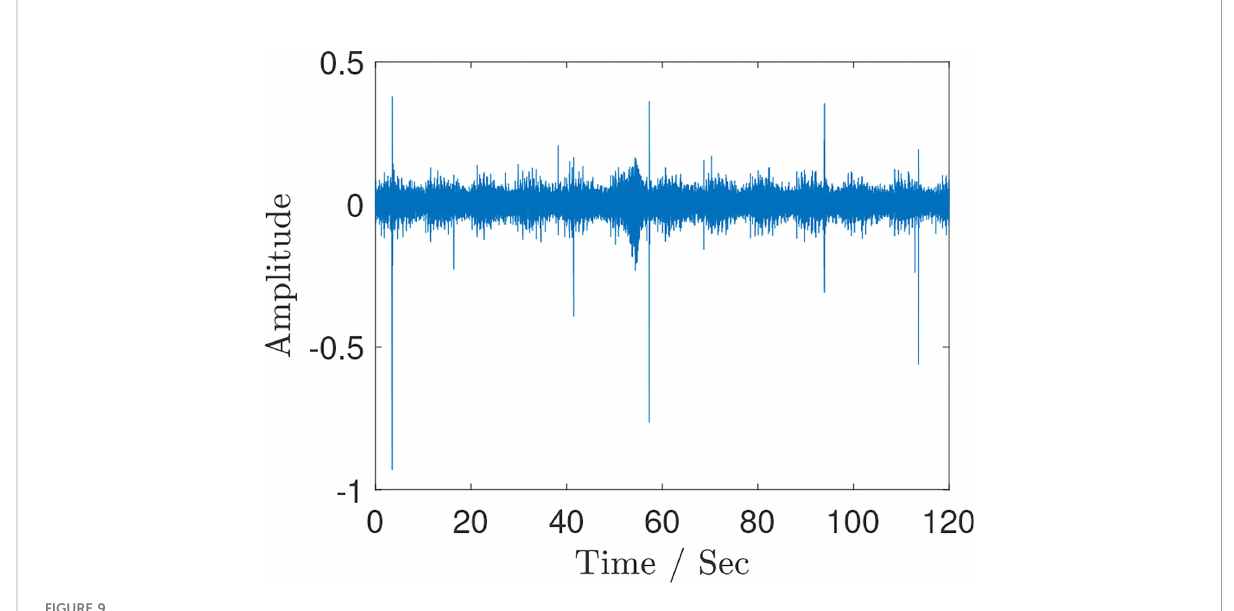
FIGURE 9 Helicopter waveform in each frame of the given audio fi